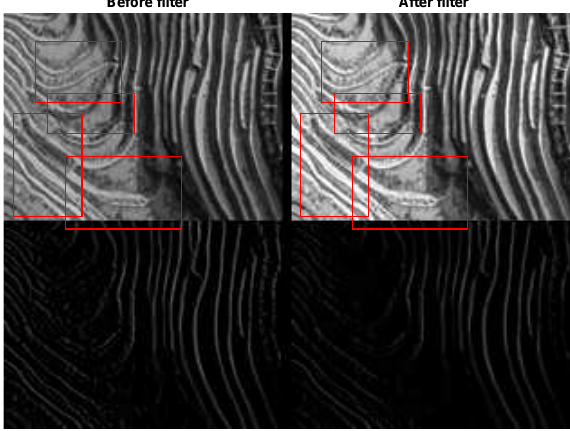
Figure 1. An example of guided image filtering. The images before and after filtering are shown in the first row, and the enhanced ridges are marked by the red windows. The image gradients before and after filtering are shown in the last row, exhibiting the gradient preserving by the